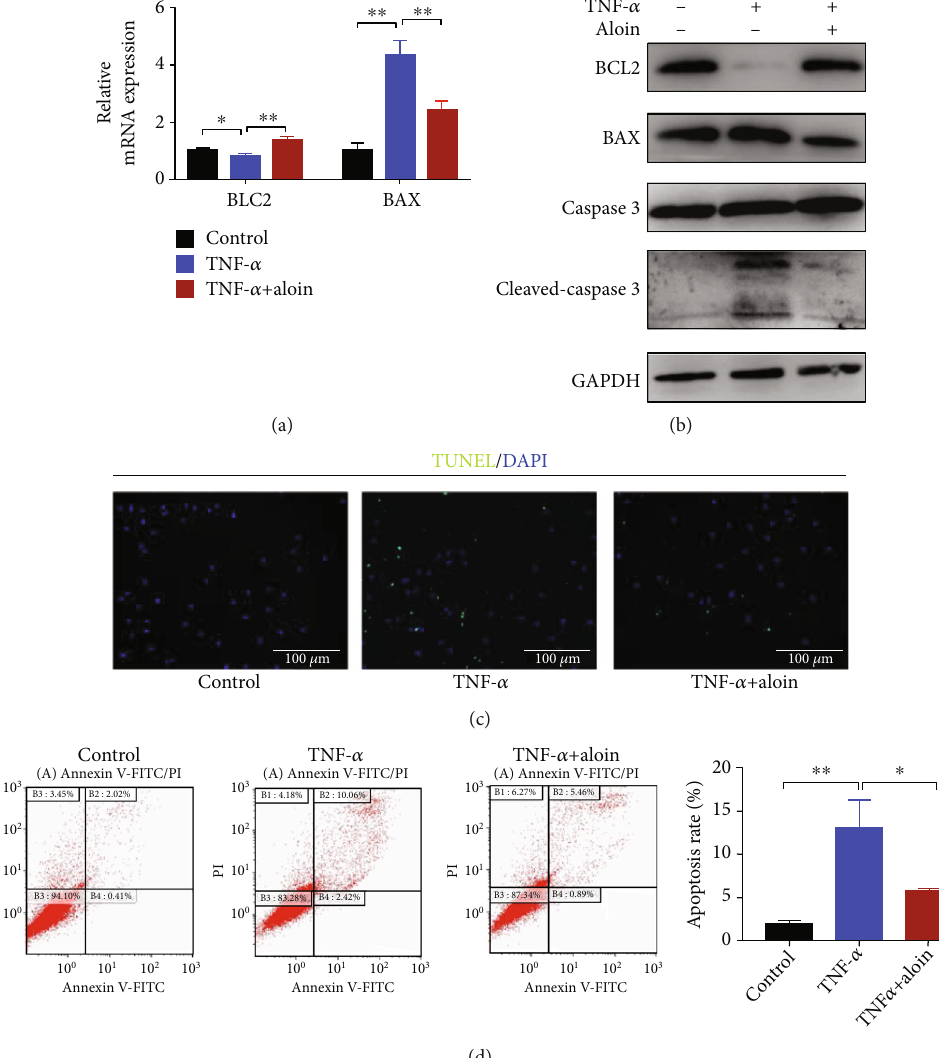
Figure 3: Aloin treatment reduced the apoptosis rate in TNF- α -treated NPCs. (a) The mRNA expression levels of BCL2 and BAX were detected by qPCR in the di ff erent groups. (b) Protein expression levels of BCL2, BAX, Caspase3, and Cleaved-caspase3 were detected by western blotting in the di ff erent groups. (c) TUNEL immuno fl uorescence staining in the di ff erent groups. (d) Flow cytometry and apoptosis rate analysis in the di ff erent groups ( n = 3 ). Images (magni fi cation: × 200, scale bar: 100 μ m). In this fi gure, aloin was used at the concentration of 200 μ M, while TNF- α was at the concentration of 10ng/ml. ∗ P < 0 : 05 , ∗∗ P < 0 : 01